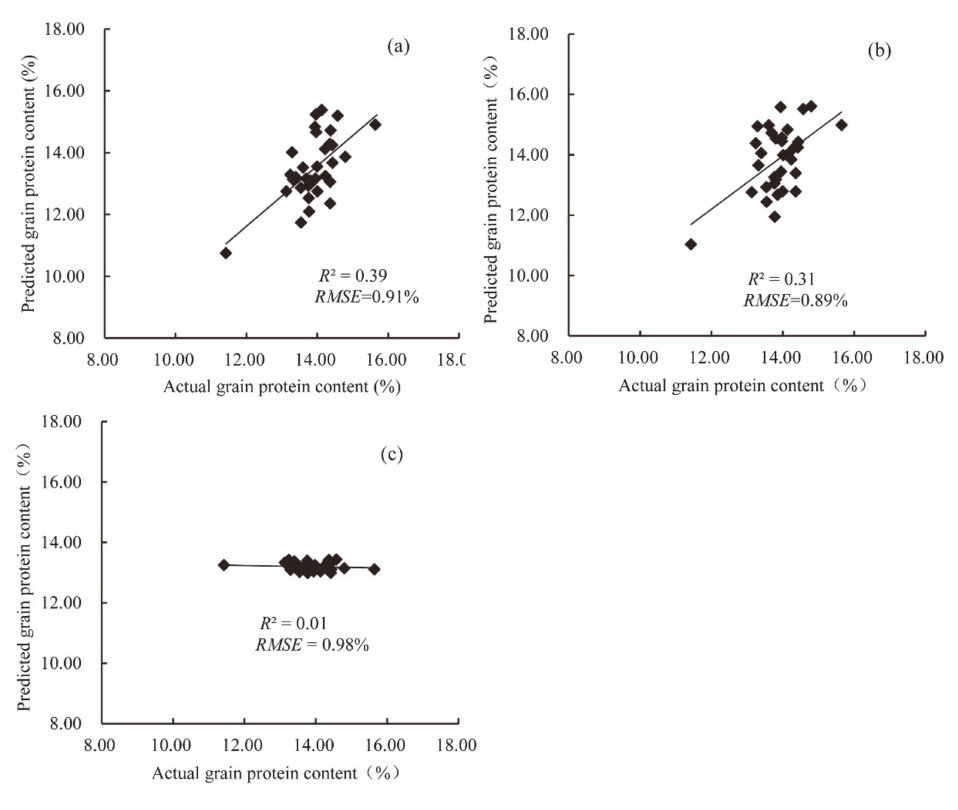
Figure 7. Predicted vs. actual GPC values for ( a ) the data assimilation method with both the LAI and LNC as state variables and using the SCE-UA algorithm to solve the cost function; ( b ) adding historical observed average LAI and LNC data as a priori knowledge; ( c ) using only the CERES-Wheat